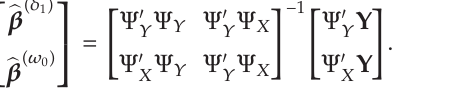
and the matrices Ψ